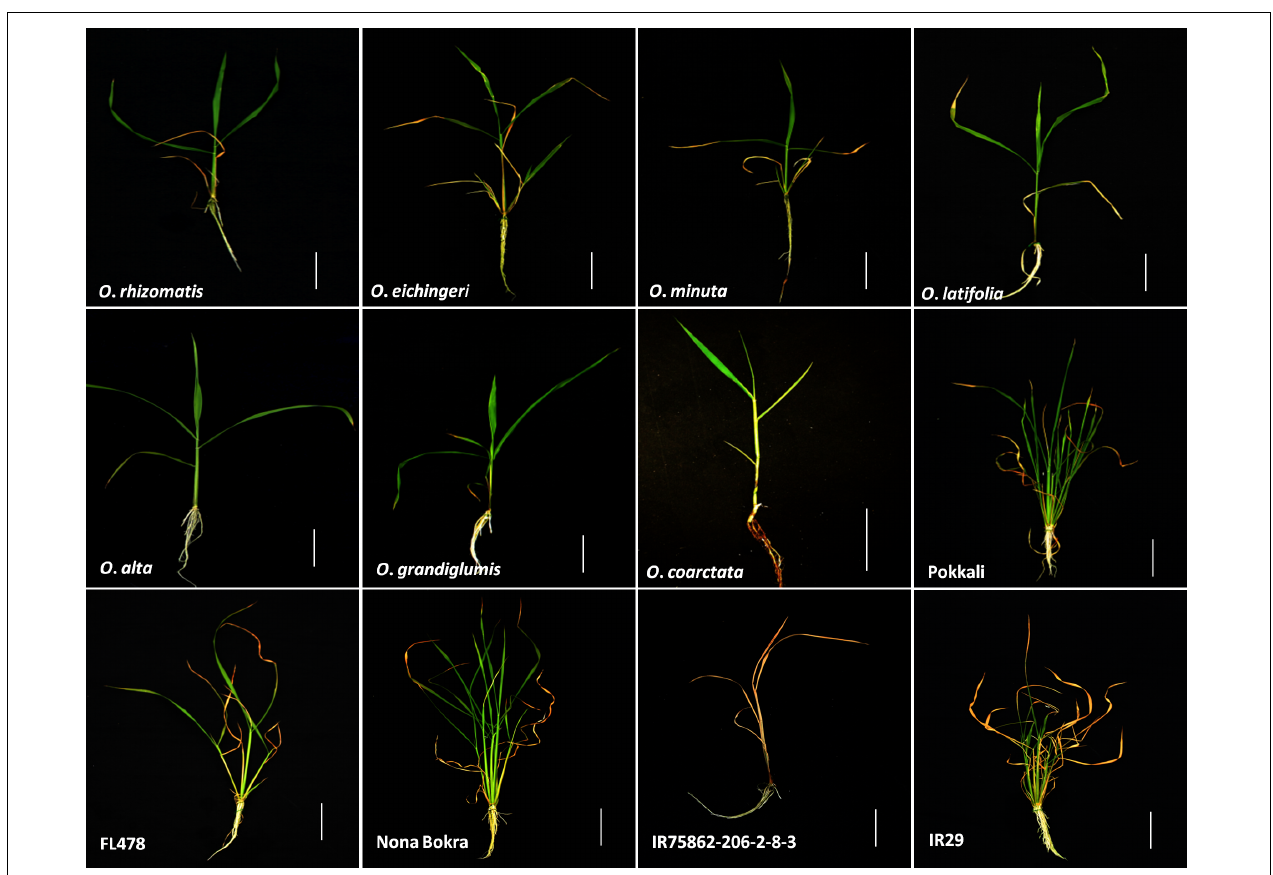
FIGURE 1 | Seedling phenotype of tolerant wild species with cultivated checks after 10 days of 180 mM NaCl treatment. Scale bar = 5